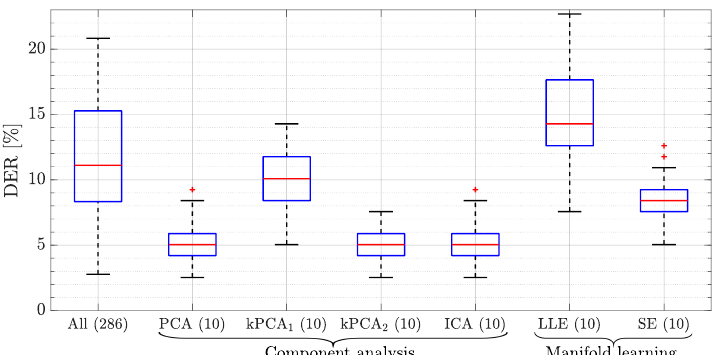
Figure 5. Diagnosis error rate (DER) of diagnosis system based on LDA for different feature extraction families and techniques. Crosses are included representing the outliers.